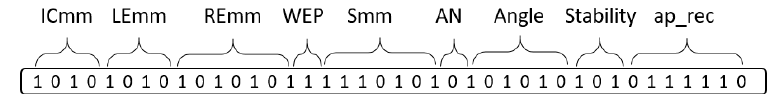
Figure 9. Flowchart of the GA implementation.